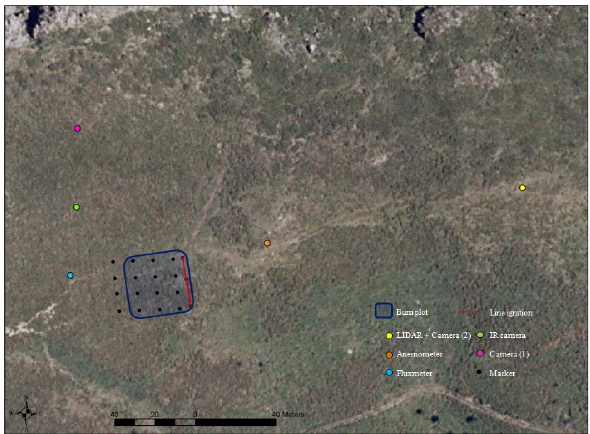
Fig. 2. Wind velocity and direction measured during the fire spread